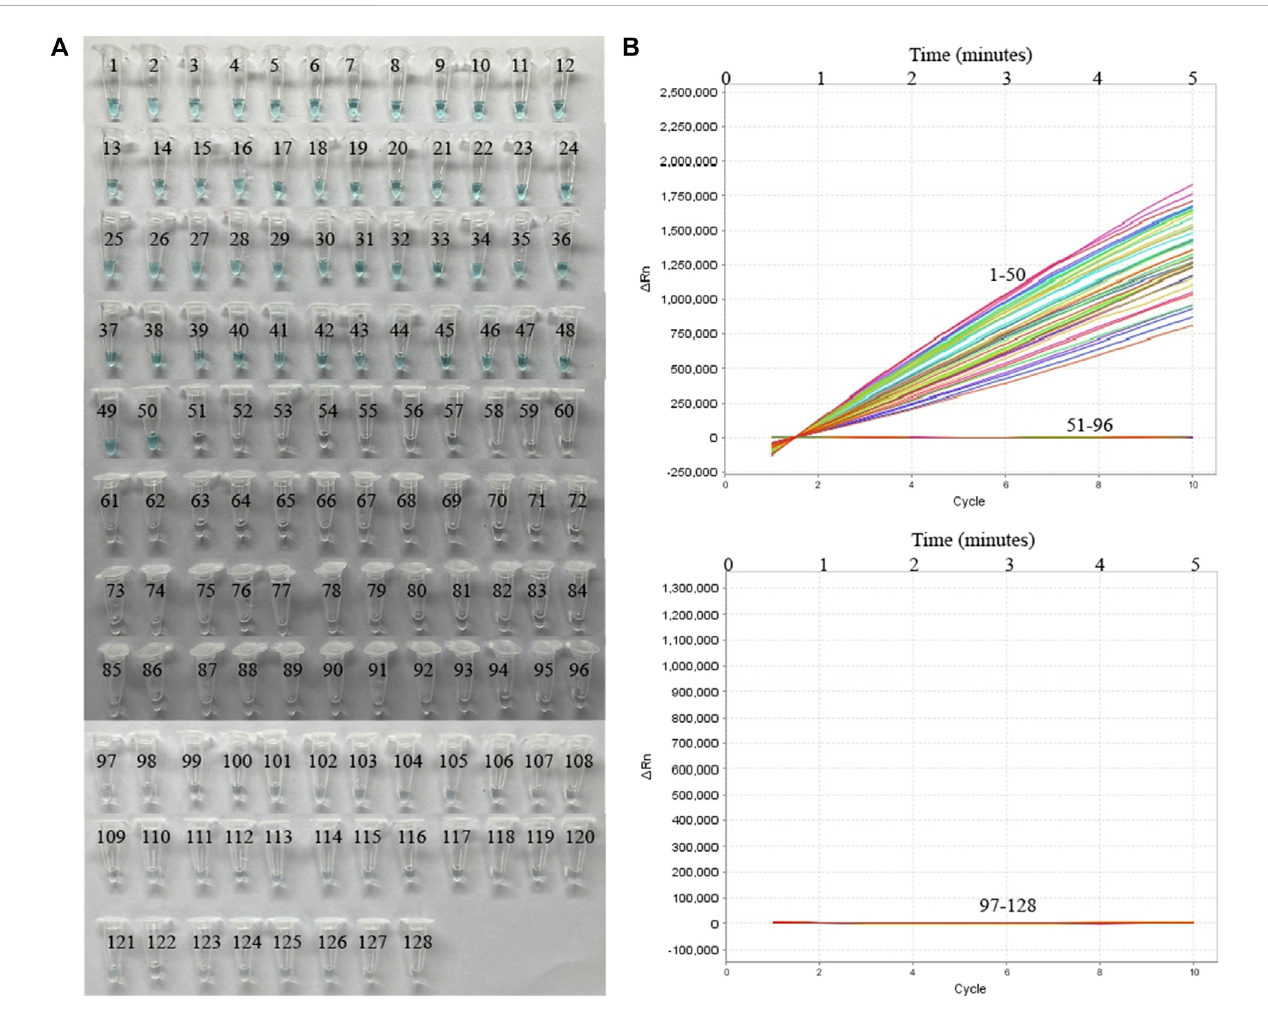
MP-MCDA-CRISPR results of 128 clinical samples suspected of MP infection. VDR (A) and RTF (B) methods were used to report the MP-MCDA-CRISPR assay results, respectively. Tubes/Curves 1 – 50 represent the 50 real-time PCR positive samples; Tubes/Curves 51 – 128 represent the 78 real-time PCR negative samples.